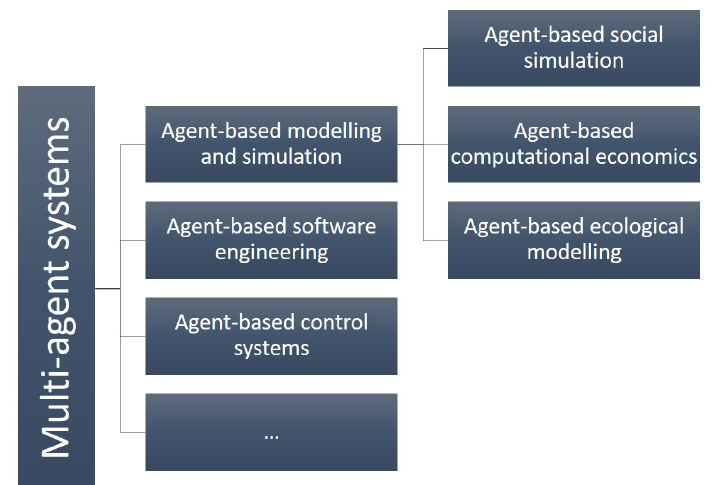
Figure 1. Representative application field of Multi-Agent Systems (based on